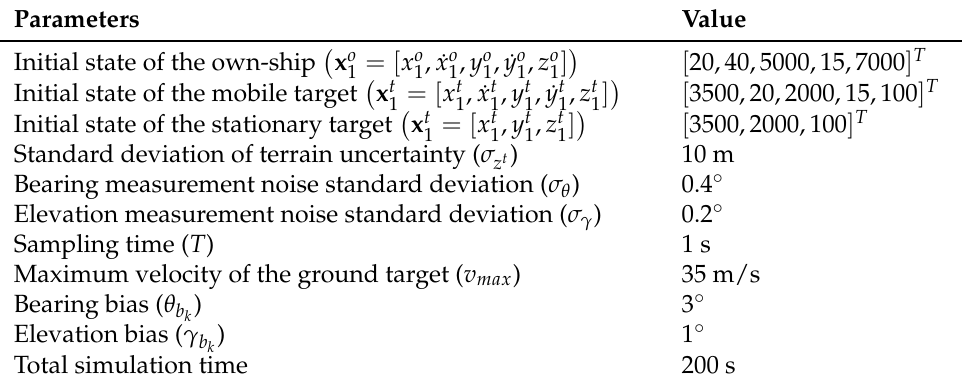
Table 3. Parameters.